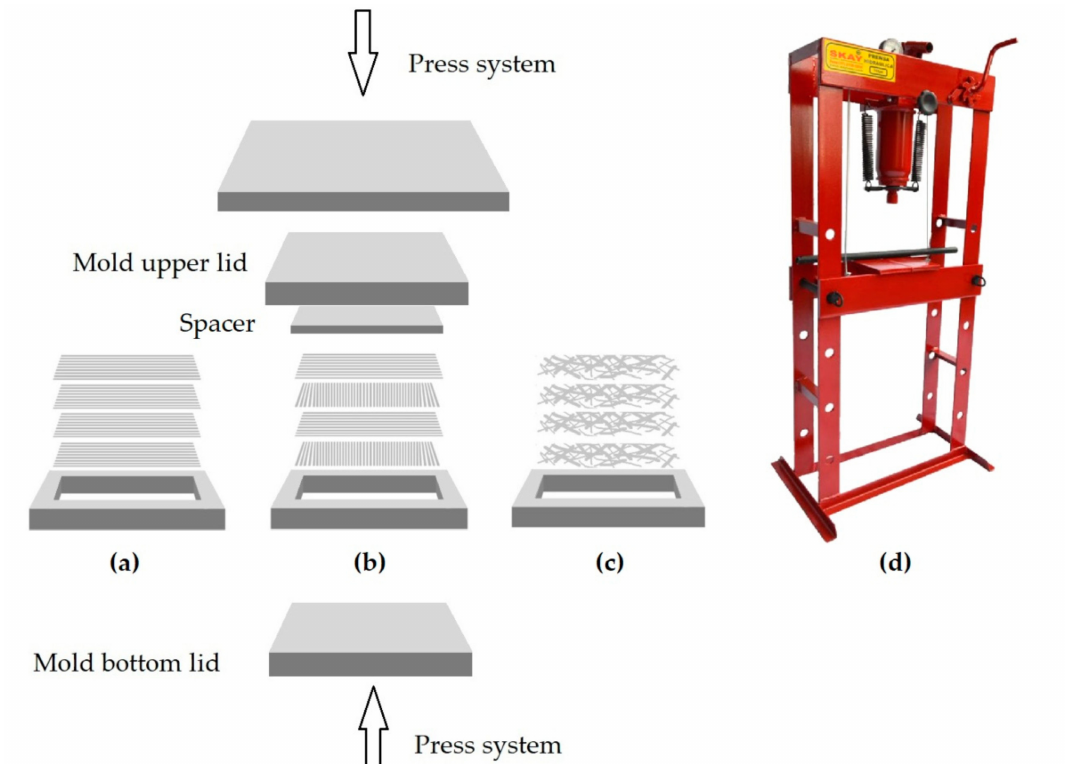
Figure 4. Schematic configurations of 30 vol% guaruman fibers in the mold: ( a ) continuous aligned, ( b ) 0–90 ◦ cross-laid, ( c ) short cut randomly dispersed, and ( d ) hydraulic